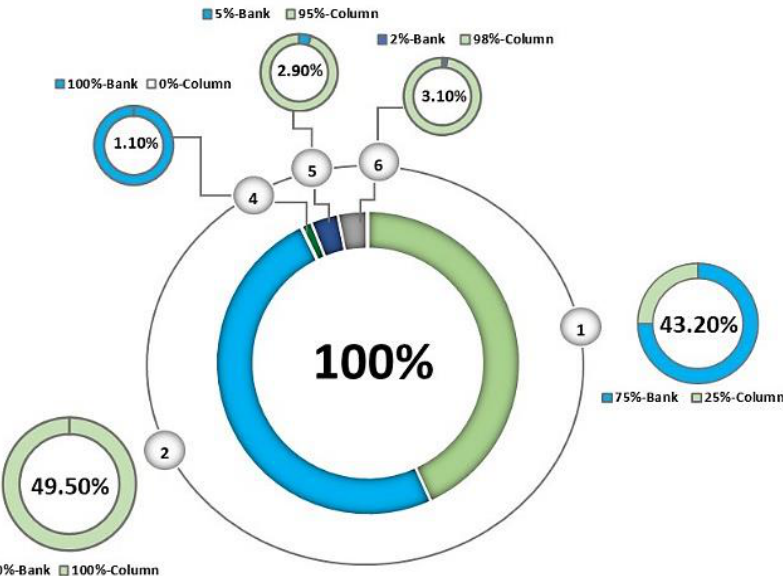
Figure 2. Graphical representation of results obtained by selecting equipment in the recleaner stage, with a copper price equal to 3500 USD/ton.